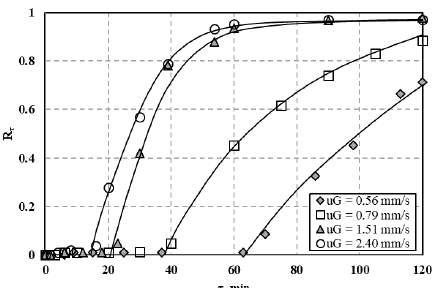
Figure A19. Changes in Al(III) temporary removal ratio during ion flotation from solution con- taining Al(III), Cu(II), and Zn(II) mixture—effect of air velocity (c 0 = 0.15 mmol dm − 3 , pH = 3.0, c SDS = 1.186 mmol dm − 3 ).